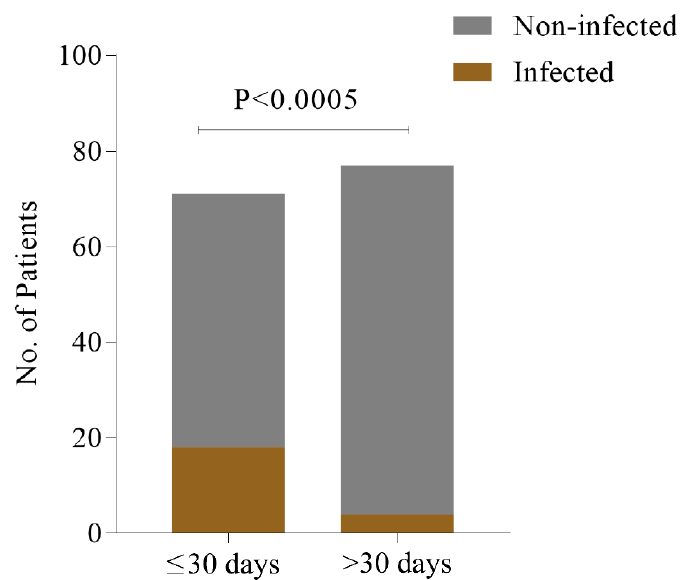
Figure 1. Comparison of infection frequency between two transfusion interval groups. The num- ber of thalassemia patients (both EBT and BTM) with HBV and HCV infection is significantly higher ( p < 0.0005) in patient group with ≤30 days transfusion interval compares to patient group with >30